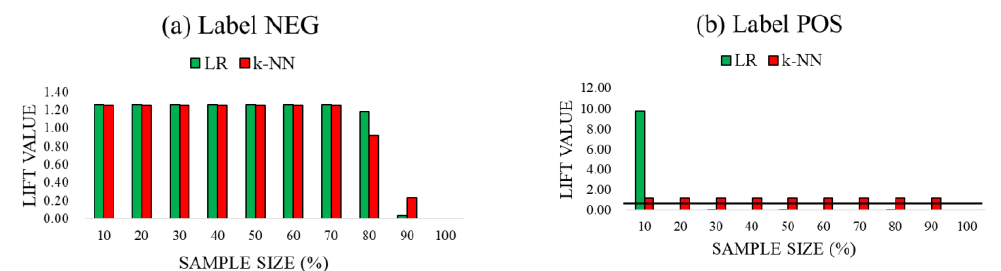
Figure 3. Decile-wise lift chart for the logistic regression (LR) and k-nearest neighbor (k-NN) models: ( a ) is for NEG class label, ( b ) is for POS class label.